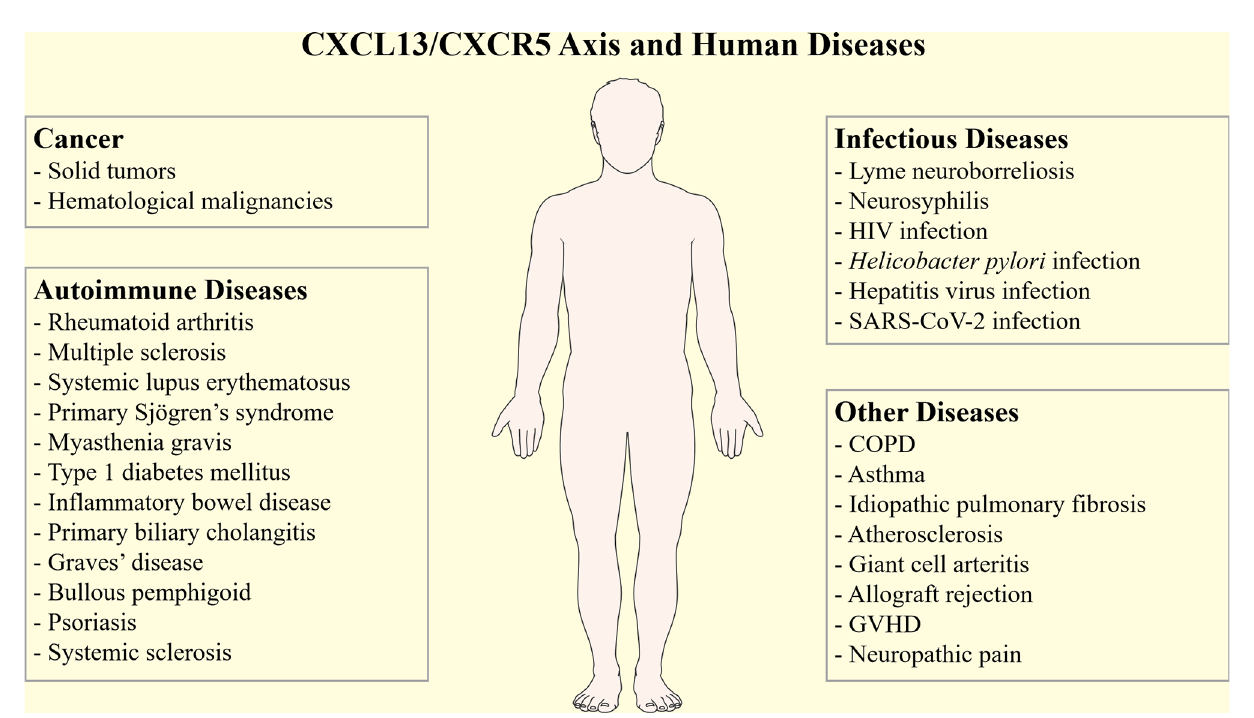
FIGURE 1 | The CXCL13/CXCR5 axis in human diseases. The CXCL13/CXCR5 axis participates in the pathogenesis and progression of many human diseases, such as cancers, autoimmune diseases, infectious diseases, idiopathic pulmonary fi brosis, transplantation rejection, and neuropathic pain. COPD, chronic obstructive pulmonary disease; GVHD, graft versus host disease; SARS-CoV-2, severe acute respiratory syndrome